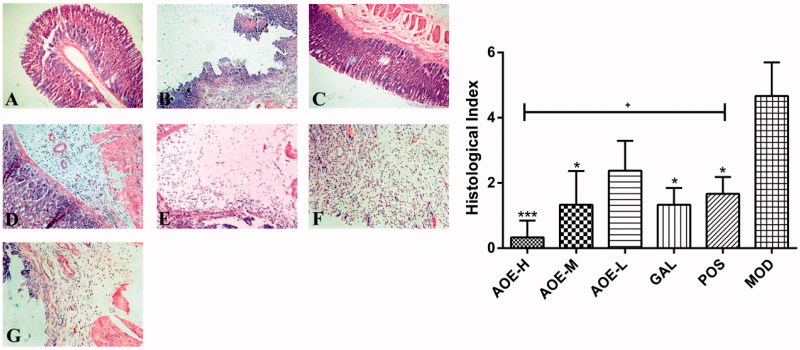
Histological findings (A–G) of the indomethacin-induced gastric damage in the rat gastric mucosa (magnification, 20×). Normal rat gastric mucosa (A) was damaged by the oral administration of indomethacin (B: 0.3 g/kg), and most of the damage was alleviated by treatment with A. officinarum extract (C: 0.18 g/kg; D: 0.09 g/kg; E: 0.03 g/kg) and galangin (F: 0.2 g/kg). (G) Treatment with 0.08 g/kg bismuth potassium citrate. Healthy rat gastric mucosa in the control group (histological index of 0) are not shown. CON: vehicle control; AOE-H: 0.18 g/kg A. officinarum extract; AOE-M: 0.09 g/kg A. officinarum extract; AOE-L: 0.03 g/kg A. officinarum extract; GAL: 0.2 g/kg galangin; POS: 0.08 g/kg bismuth potassium citrate; MOD: 0.3 g/kg indomethacin. +p < 0.05 compared with the POS group; *p < 0.05 and ***p < 0.001 compared with the MOD group.